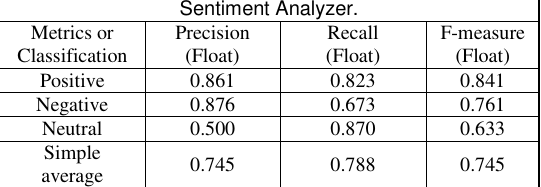
Table 3: Precision, Recall and F-Measure of Urdu Sentiment Analyzer.